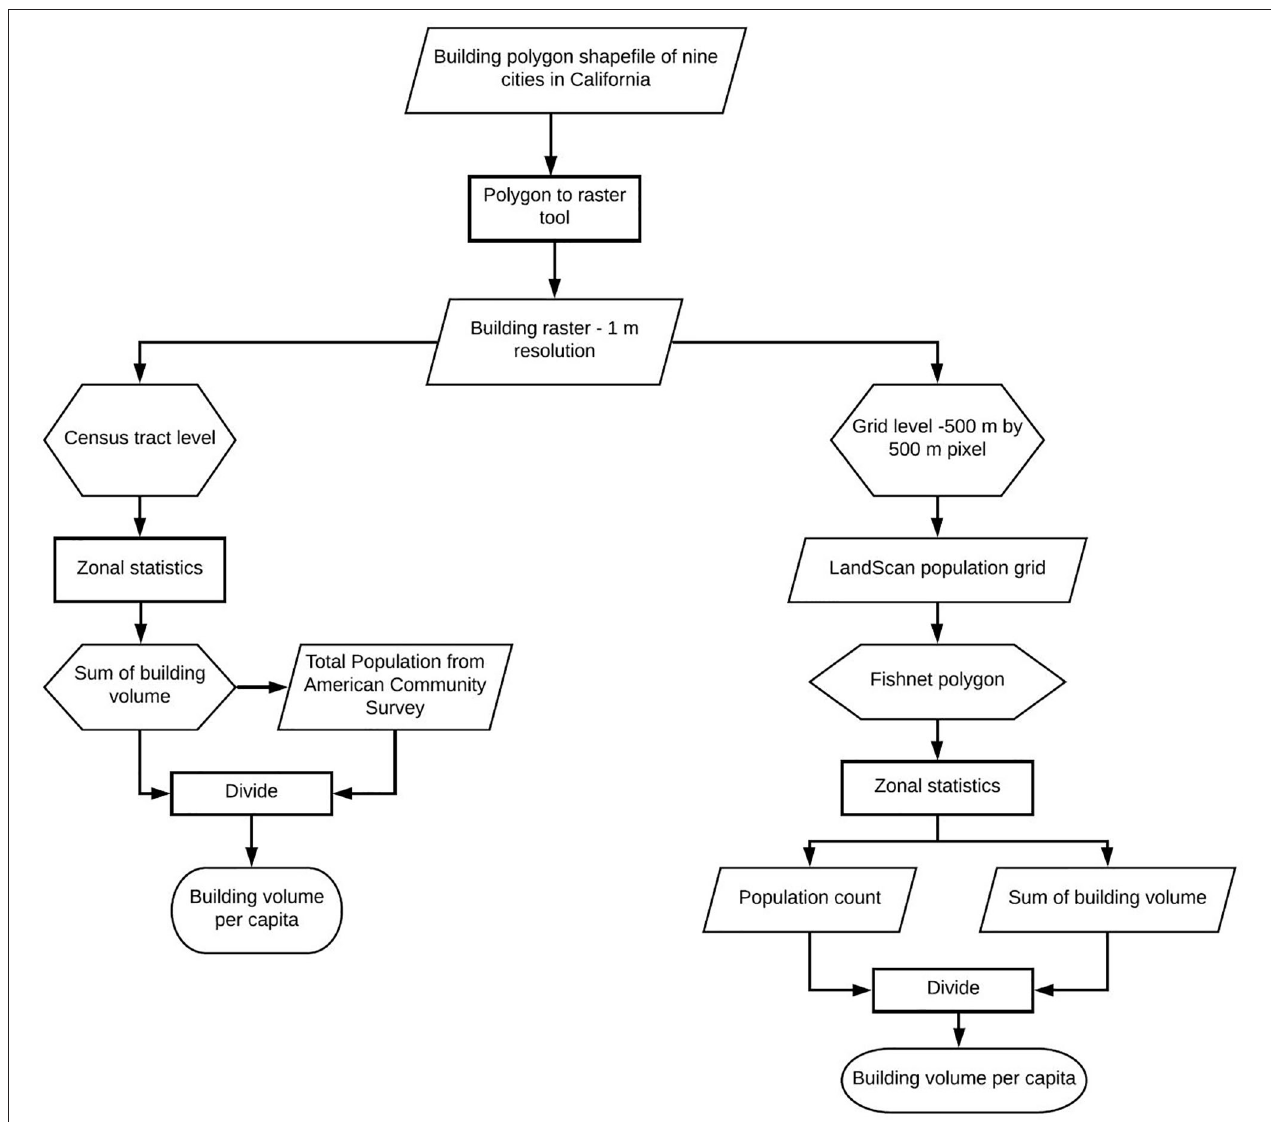
FIGURE 1 | Flow chart of GIS